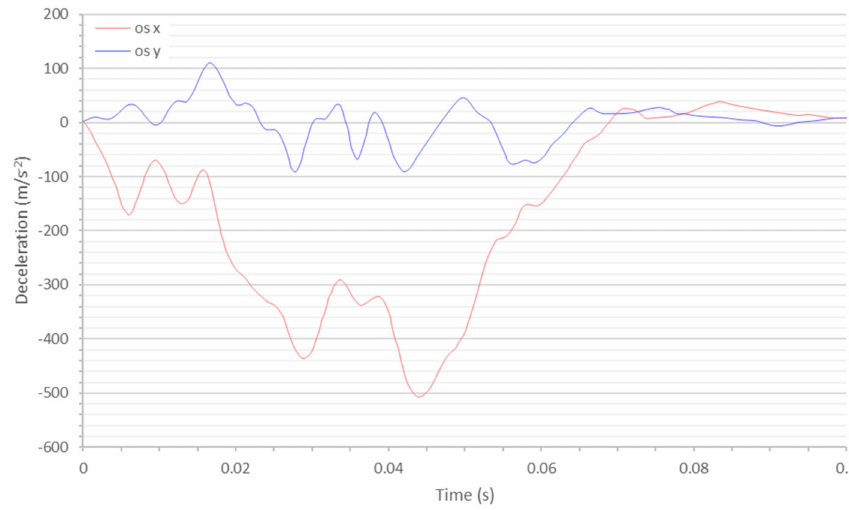
Figure 12. Decelerations during a crash test (speed: 54 km/h, rigid barrier, full overlap, 0 ◦ impact angle)